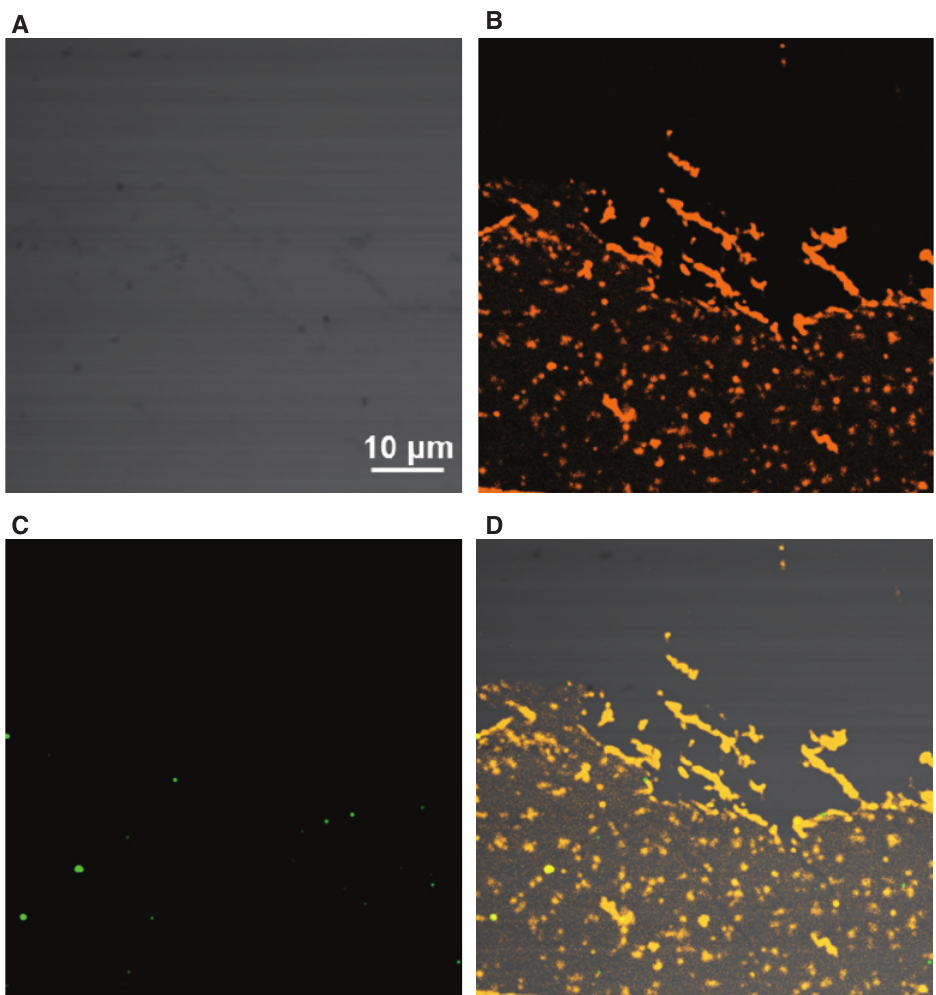
Figure 7: (A) Bright field of monolayer graphene. (B) CARS image of graphene. (C) TPEF + SHG image of graphene. (D) The merged image of bright field + CARS + TPEF + SHG at Raman mode 1560 cm −1